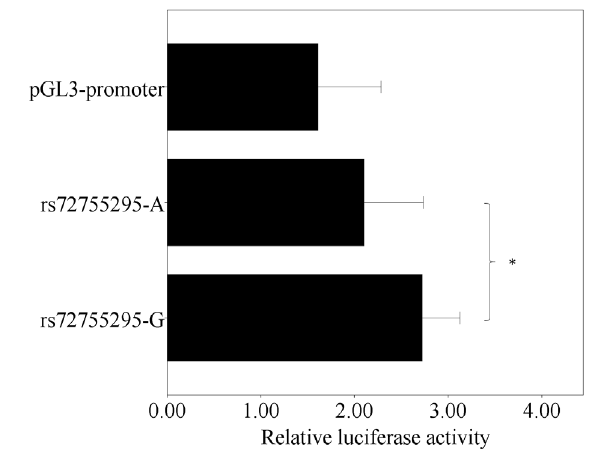
Figure 1 – Relative luciferase activity for different rs72755295 alleles in MCF-7 cell. The x axis represents relative enhancer activity. All data are expressed as mean ± standard deviation (SD). * indicates P <0.01.